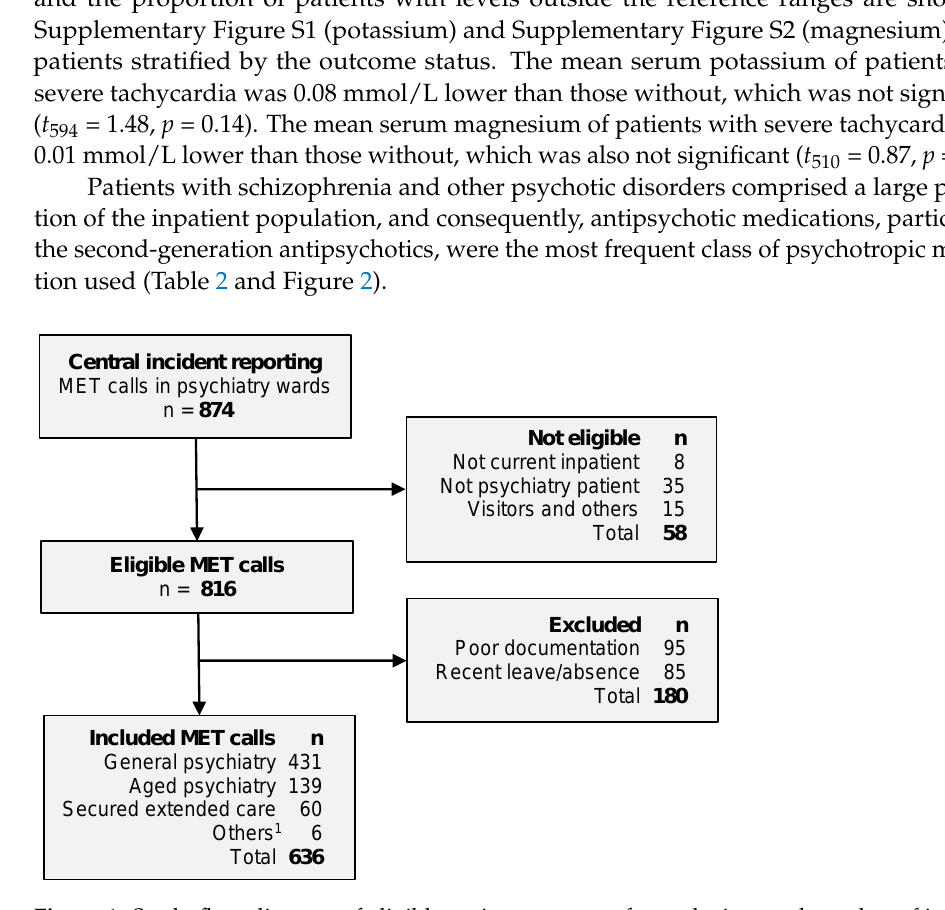
Figure 1. Study flow diagram of eligible patients, reasons for exclusion, and number of included patients by location. 1 Includes eating disorders and mother–baby unit. Abbreviation: MET, Medical Emergency Team.